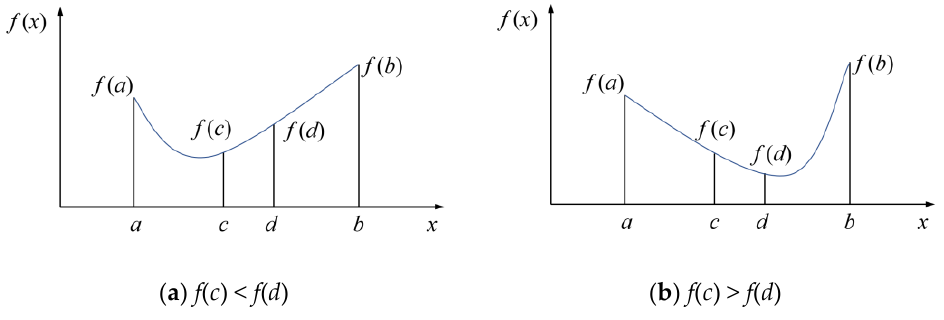
Figure 7. Schematic diagram of the golden section method.